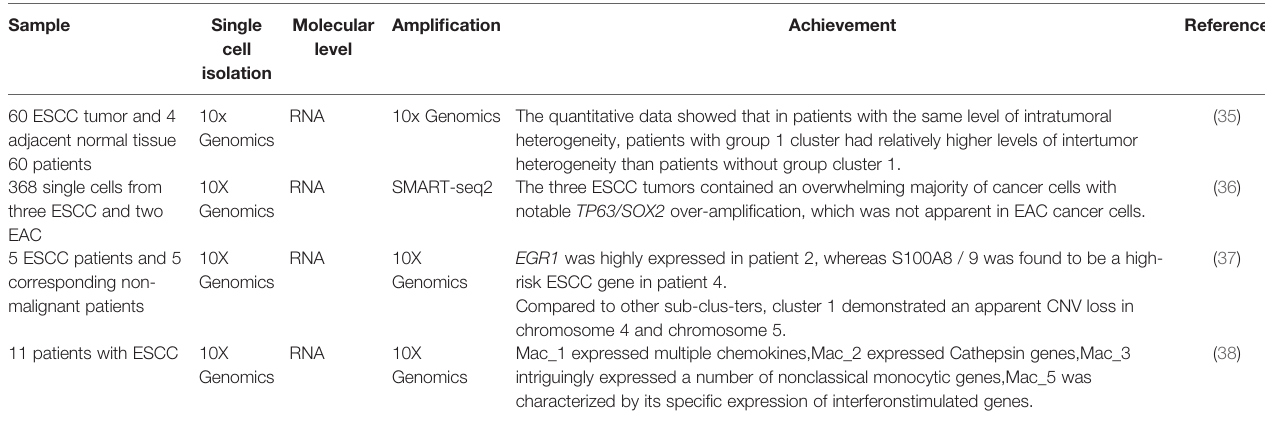
TABLE 4 | SCS in esophageal cancer